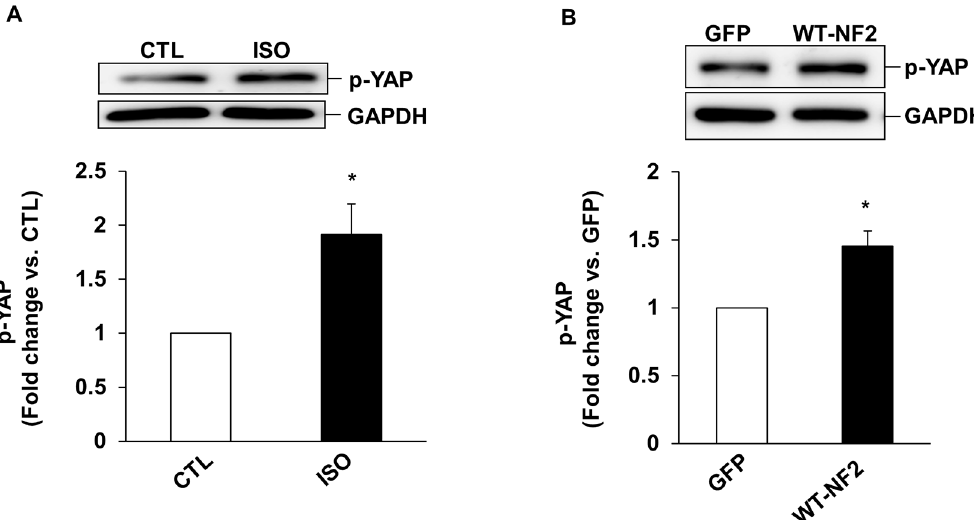
Fig 6. Stimulation of β -AR and adenoviral-mediated expression of NF2 increase YAP phosphorylation. ARVMs were treated with ISO for 15 min (A) or infected with adenoviruses expressing WT-NF2 or GFP for 48 h (B). Total cell lysates were analyzed by western blot using phospho-specific anti-YAP antibodies. There was no significant change in total YAP expression following ISO treatment. Therefore, data was normalized to GAPDH. The lower panels exhibit the mean data normalized to GAPDH, (cid:3) p < 0.05 vs CTL or GFP; n = 3–7.